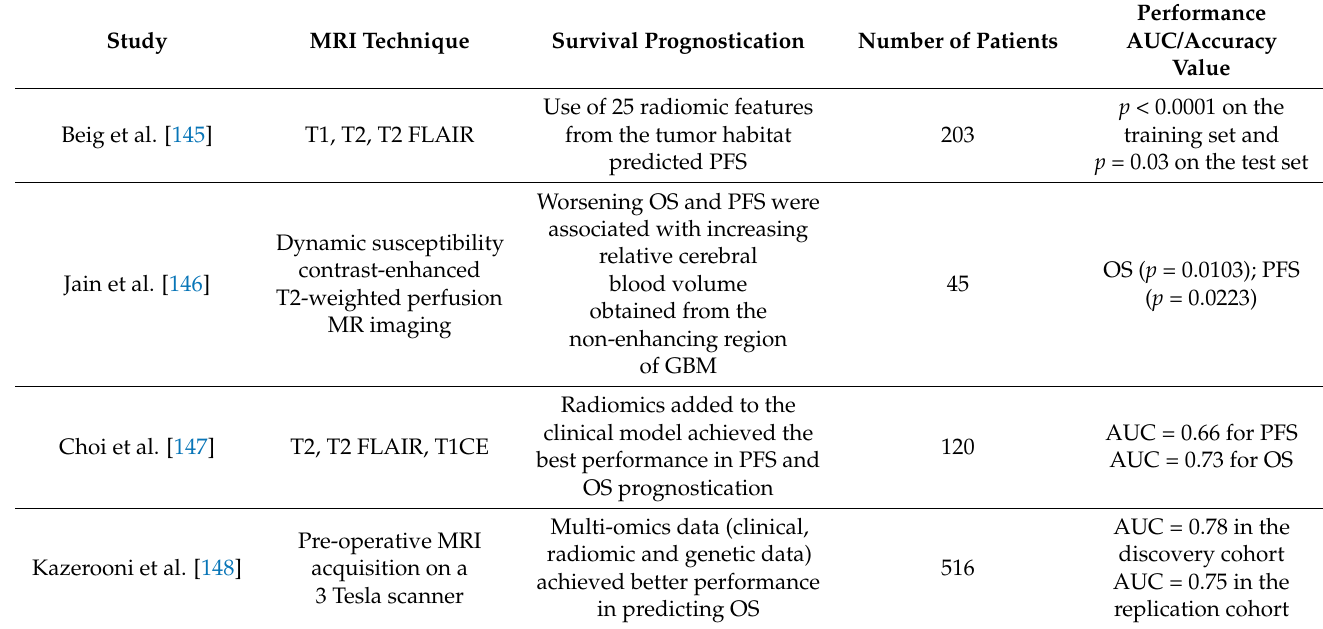
Table 3. GBM survival